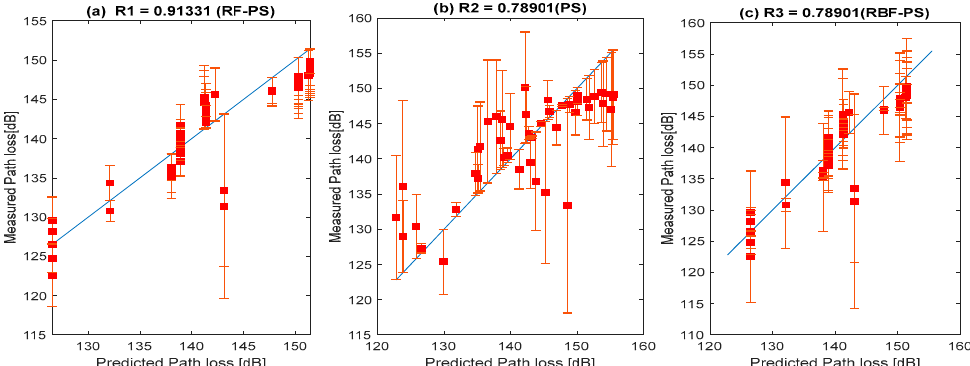
Figure 21. Results showing the correlation between the measured path loss and predicted path loss using the hybrid RF-PS prediction method and two existing standard path loss prediction methods in site 2 of location 1.